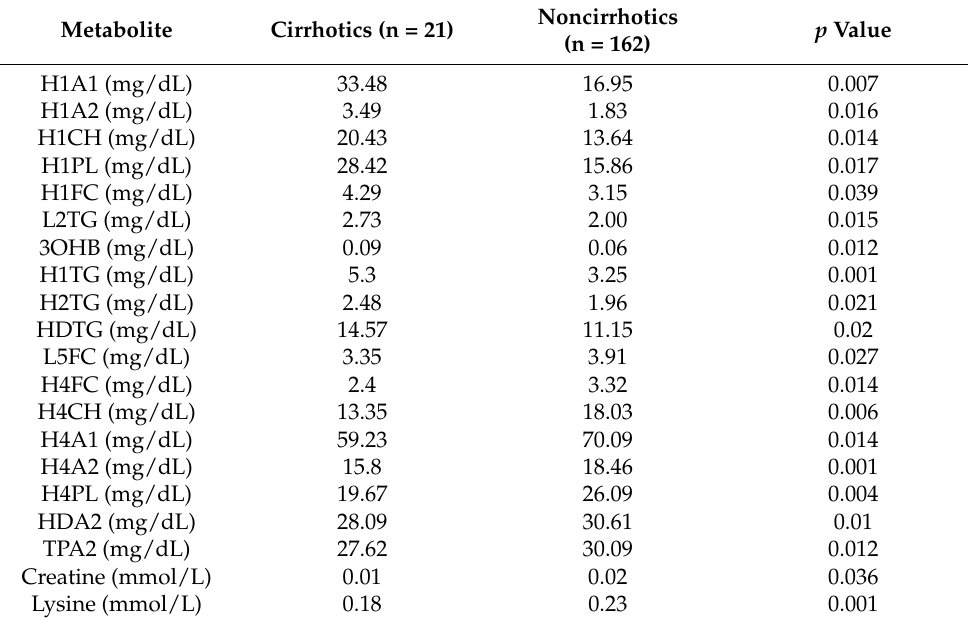
Table 5. Differences in metabolic profile between cirrhotic and noncirrhotic patients.